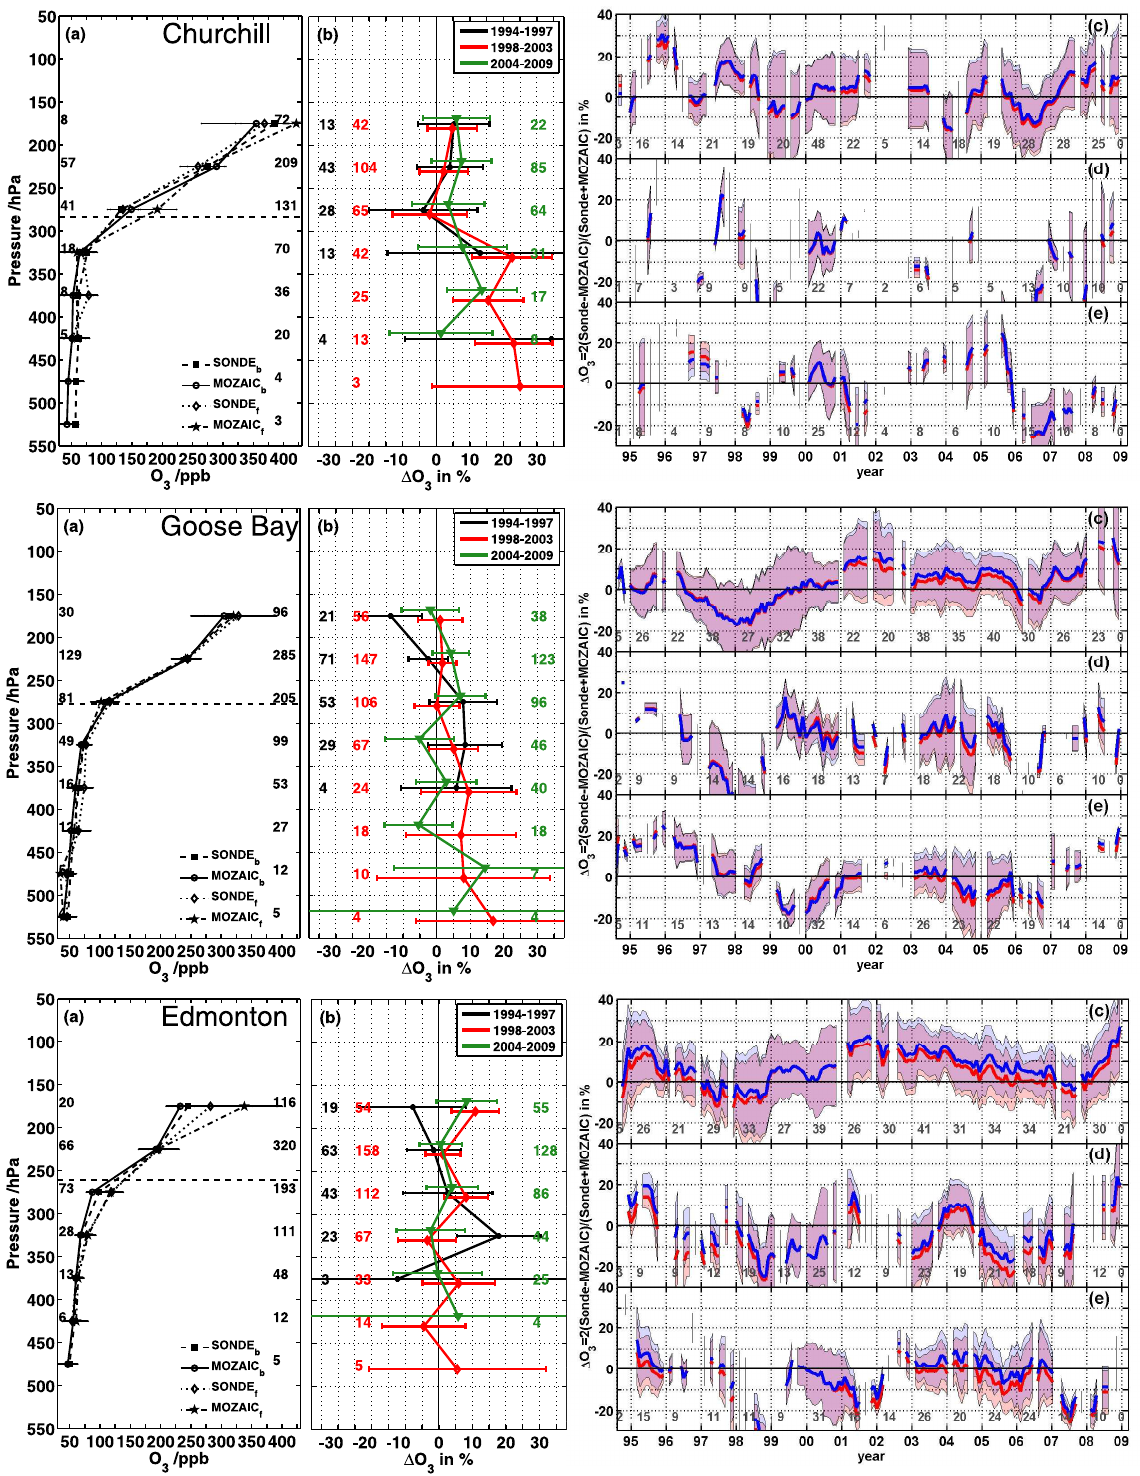
Fig. 8. Comparisons of ozonesondes with MOZAIC measurements. As for Fig. 3, but for Churchill, Edmonton, and Goose Bay. At all three launch sites both SP and ES-Z sondes were flown before 2004. After 2004 mainly ES sondes were launched but the 1.0% solution strength was retained 45